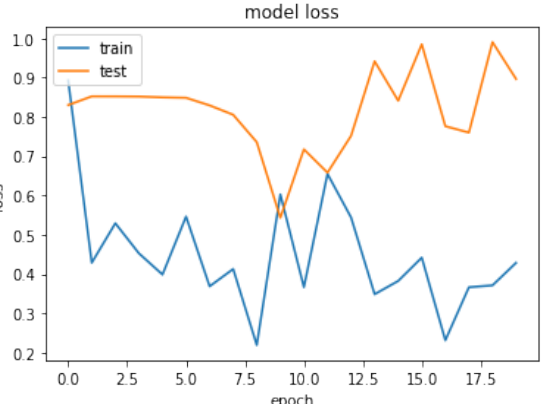
Figure 16. Loss over 20 epochs during the model ResUNet’s training progress for liver segmenta- tion intervals.